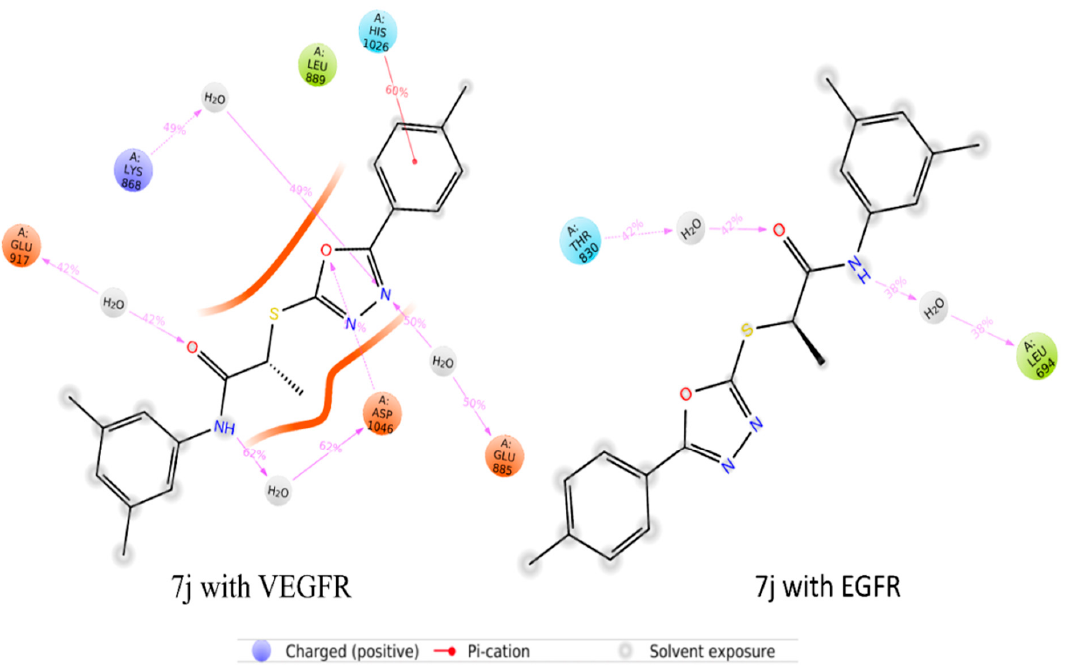
Figure 14. Ligand atom interactions with the amino acid residues of target proteins. ( 7j-VEGFR 2 and 7j-EGFR ).